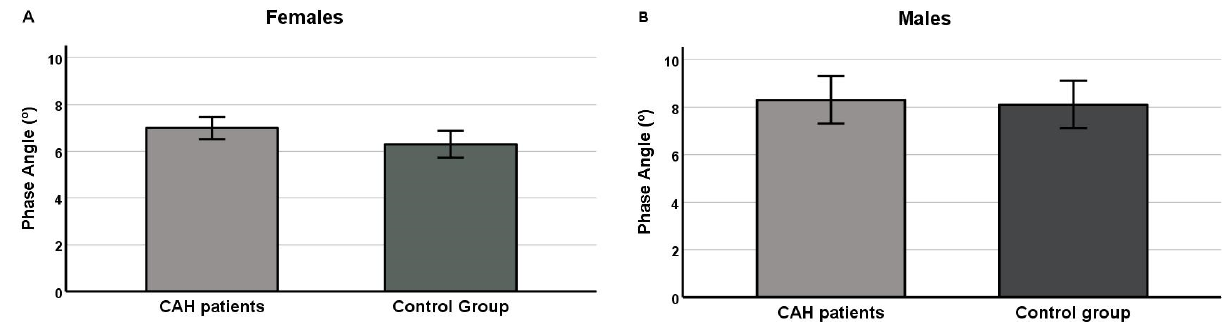
Figure 1. Estimated means of the phase angle value of groups and according to sex. Females ( A ): adjusted for age (24.61 years) and height (157.5 cm); F = 3.109, p = 0.092; E.S = 0.12. Males ( B ): adjusted for height (166.30 cm); F = 0.038 p = 0.849; E.S = 0.004.